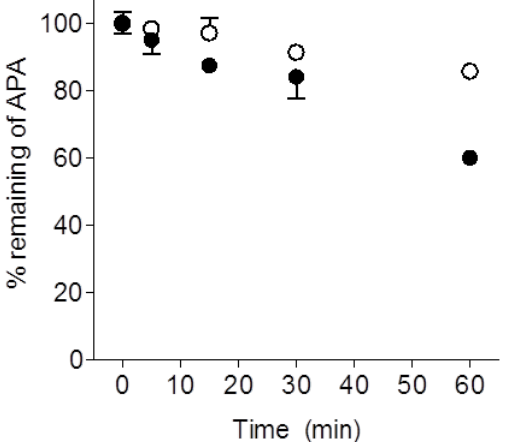
Figure 4. Time course of APA depletion following incubation of APA in mouse liver microsomes. APA (1 µM) was incubated with 0.5 mg/mL of pooled mouse liver microsomes in the absence ( ○ ) or